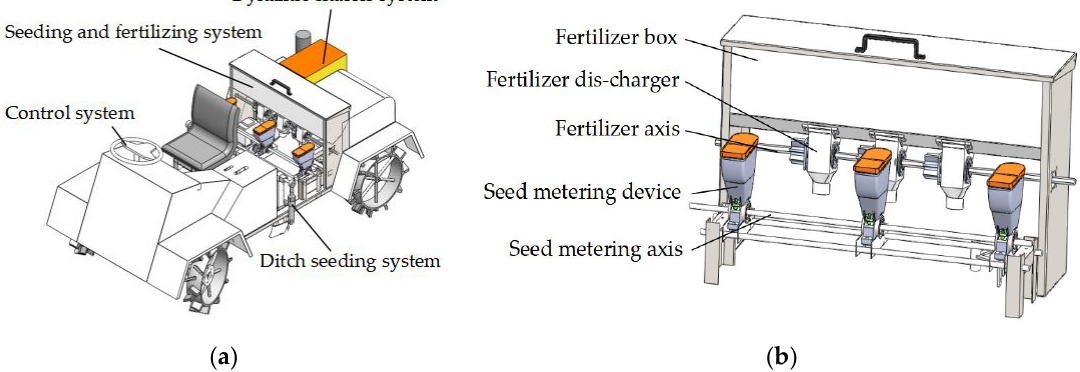
Figure 1. Self-propelled industrial hemp seeder. ( a ) Whole structure ( b ) Seeding and fertilizing system.